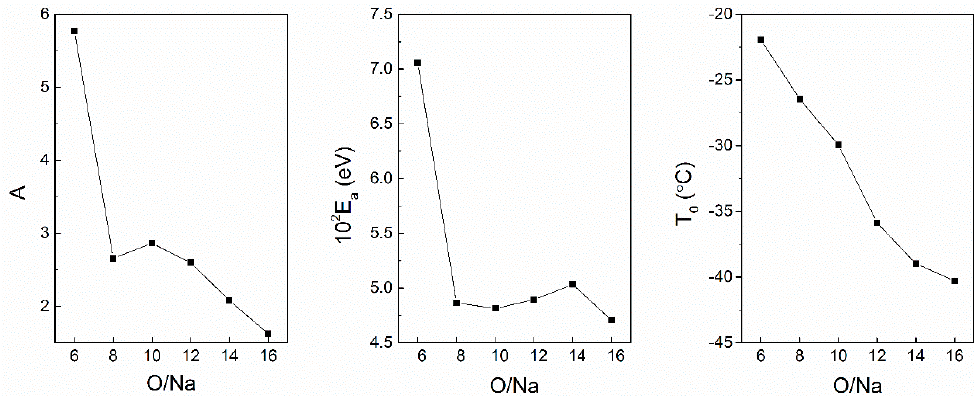
Figure 2. Variation of three parameters: pre-exponential factor ( A ), activation energy ( E a ), reference temperature ( T 0 ) within the Vogel-Tamman-Fulcher (VTF) equation for poly(propylene oxide) (PPO)-sodium triflate system at different salt concentrations expressed in the X -axis as O/Na ratio. Data from Armand et al. [20].